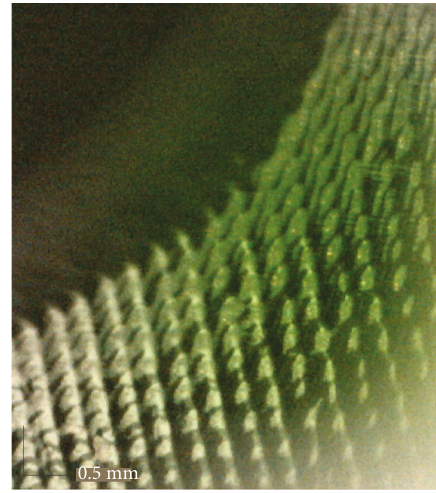
Figure 5: Microscopy image of the DLP printed components showing the voxel e ff ect on the surface fi nish.